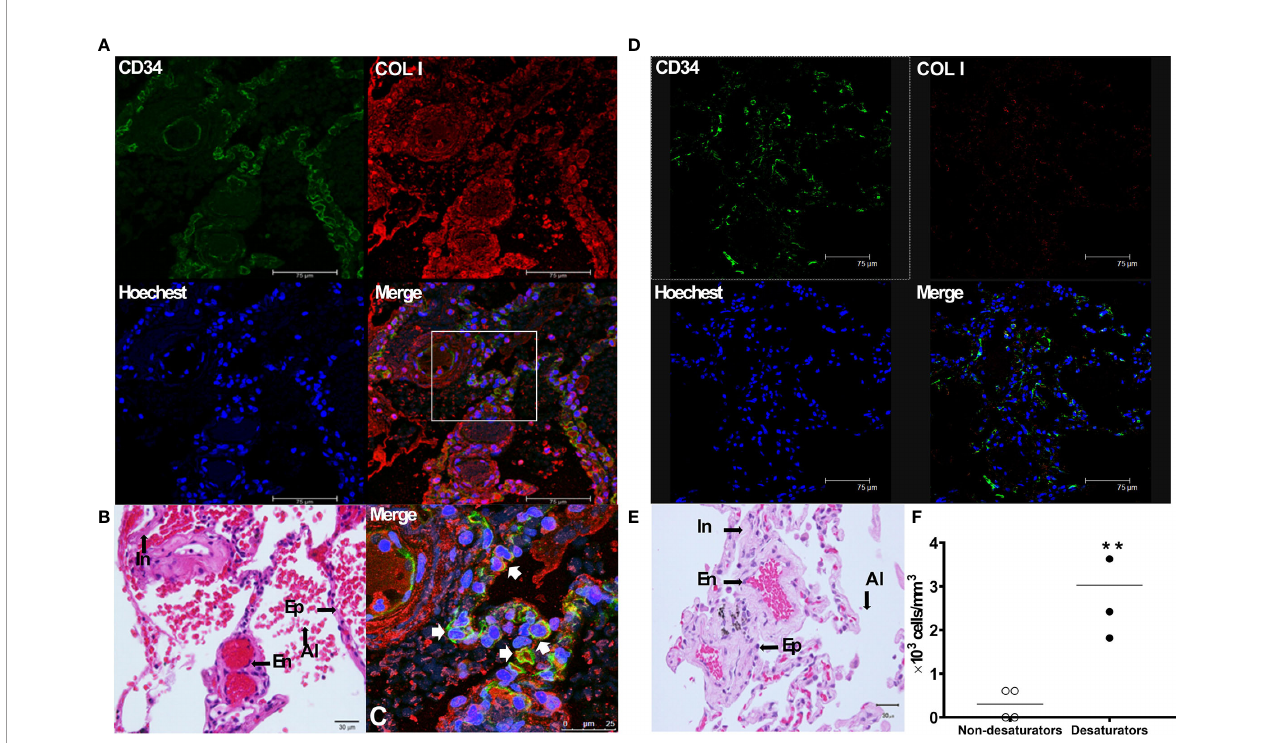
FIGURE 4 | Identi fi cation of COL I + /CD34 + fi brocytes in the lung tissue of COPD desaturators (A – C) . The paraf fi n sections of lung tissue from COPD desaturators were stained for the CD34 surface marker ( green ), intracellular COL I ( red ), and nuclei ( blue ) (A) , and for hematoxylin and eosin staining (B) . The immuno fl uorescence staining and confocal microscopic analysis are described in Methods. (C) Shows a magni fi cation of the merged image of (A) , and arrows indicate the double staining of COL I + /CD34 + fi brocytes with yellow enhancement in the merged image. Bar , 75 m m (A) and 25 m m (C) . (D, E) The paraf fi n sections of airway tissue from COPD non-desaturators were stained for indicated immuno fl uorescence staining (D) and hematoxylin and eosin staining (E) , as described above. Bar , 75 m m (D) and 30 m m (E) . (F) The differences between the numbers of fi brocytes in specimens from non-desaturators and desaturators were determined by Mann-Whitney test. ** P < 0.01. COL I, collagen I; COPD, chronic obstructive pulmonary disease; In, interstitium; Ep, epithelium; En, endothelium; Al,